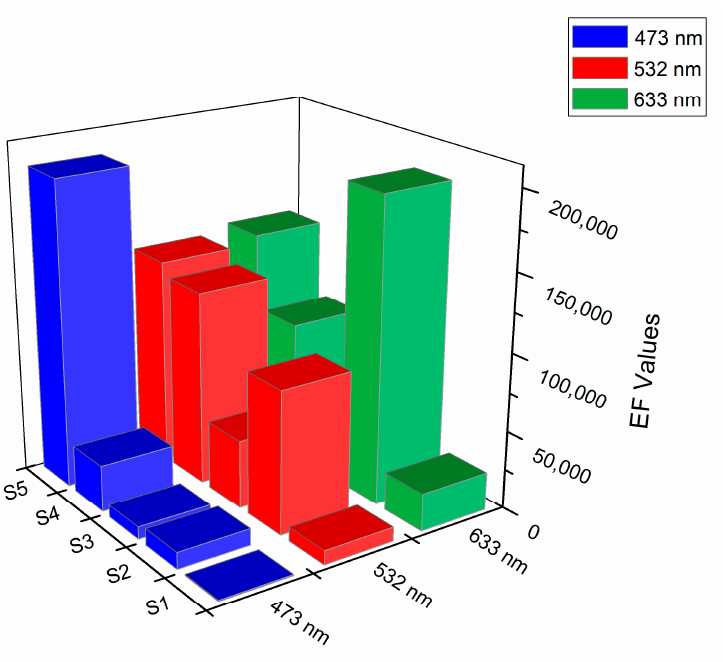
Figure 6. The EF values of the different substrates at different excitation wavelengths.